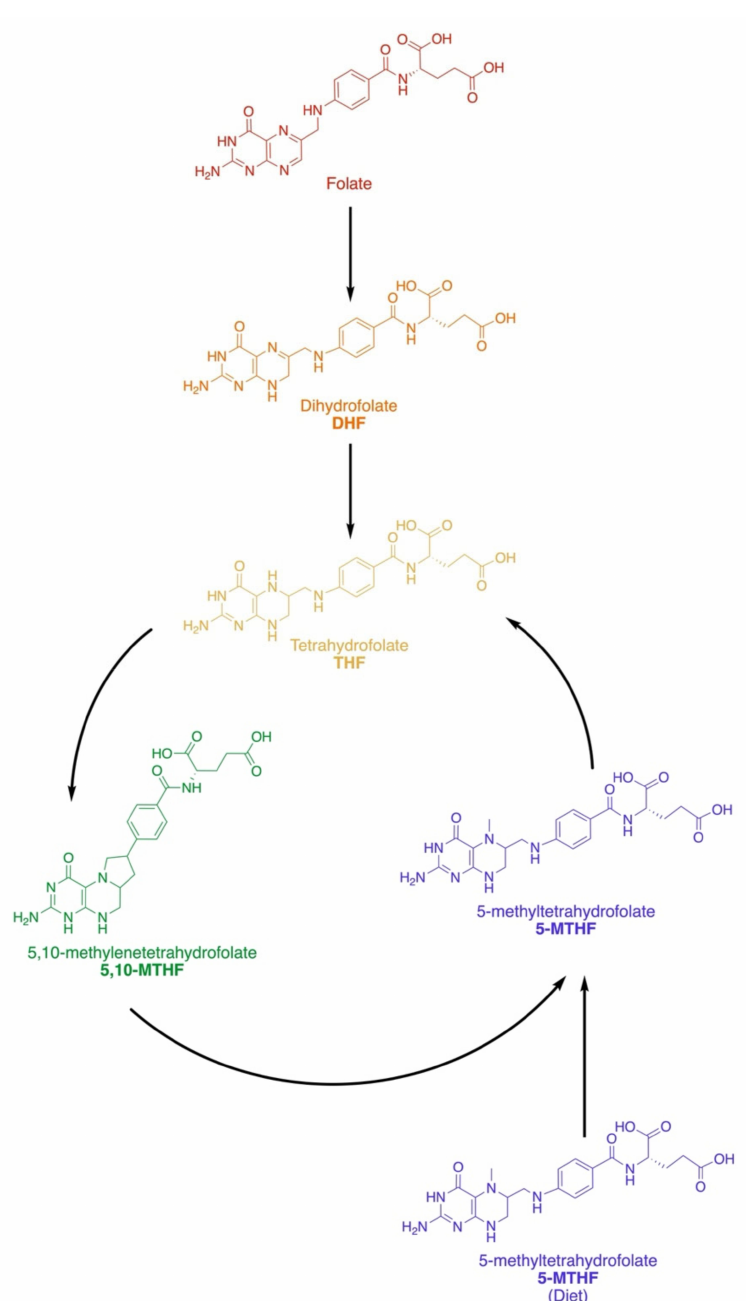
Figure 2. Vitamin B9 and the Folate Family. Folate or folic acid is obtained from diet and must be converted to tetrahydrofolate (THF) before it can enter the folate cycle. Dietary 5-methyl-THF can also become incorporated. Folate is converted first to dihydrofolate (DHF) before becoming THF, the universal methyl-acceptor of the one carbon pathway. Methylation can occur on the 5 or 10 N groups of THF in 5,10-methylene-THF and